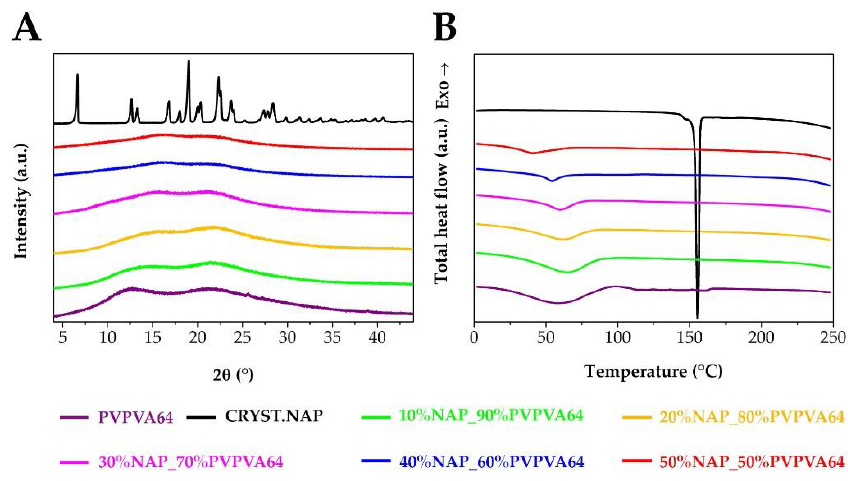
Figure 4. The ( A , B ) parts of the Figure present XRPD patterns and DSC thermograms of the samples